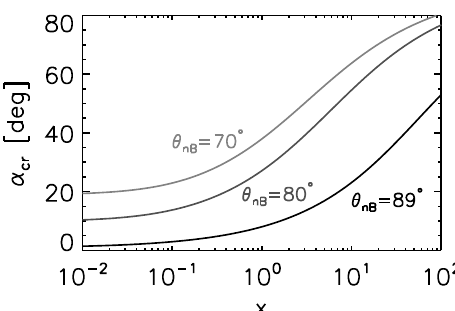
Figure 1. Critical pitch angle as a function of the dimensionless quantity x for different values of the shock angle between the up- stream magnetic field and the shock normal direction θ nB